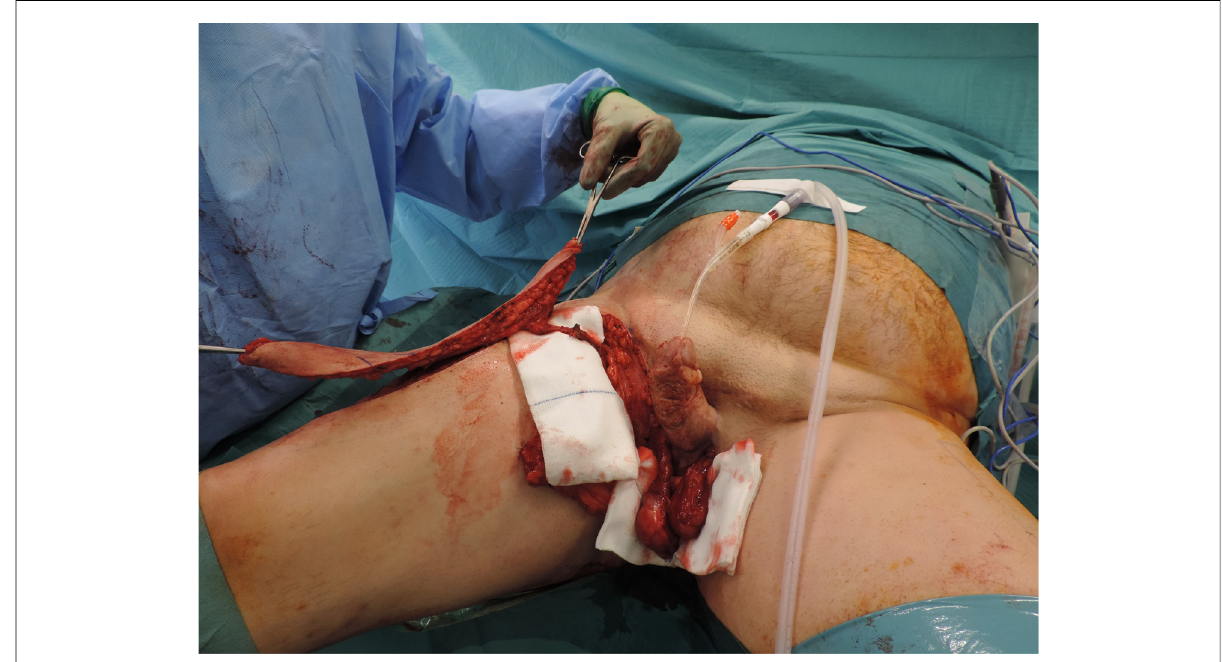
FIGURE 1 Typical outcome of perineal reconstruction after Fournier ’ s gangrene. In this case, the pedicled anterolateral thigh fl ap was used to reconstruct both the perineum and scrotum. The fl ap is tunneled under the Sartorius in order to reach the